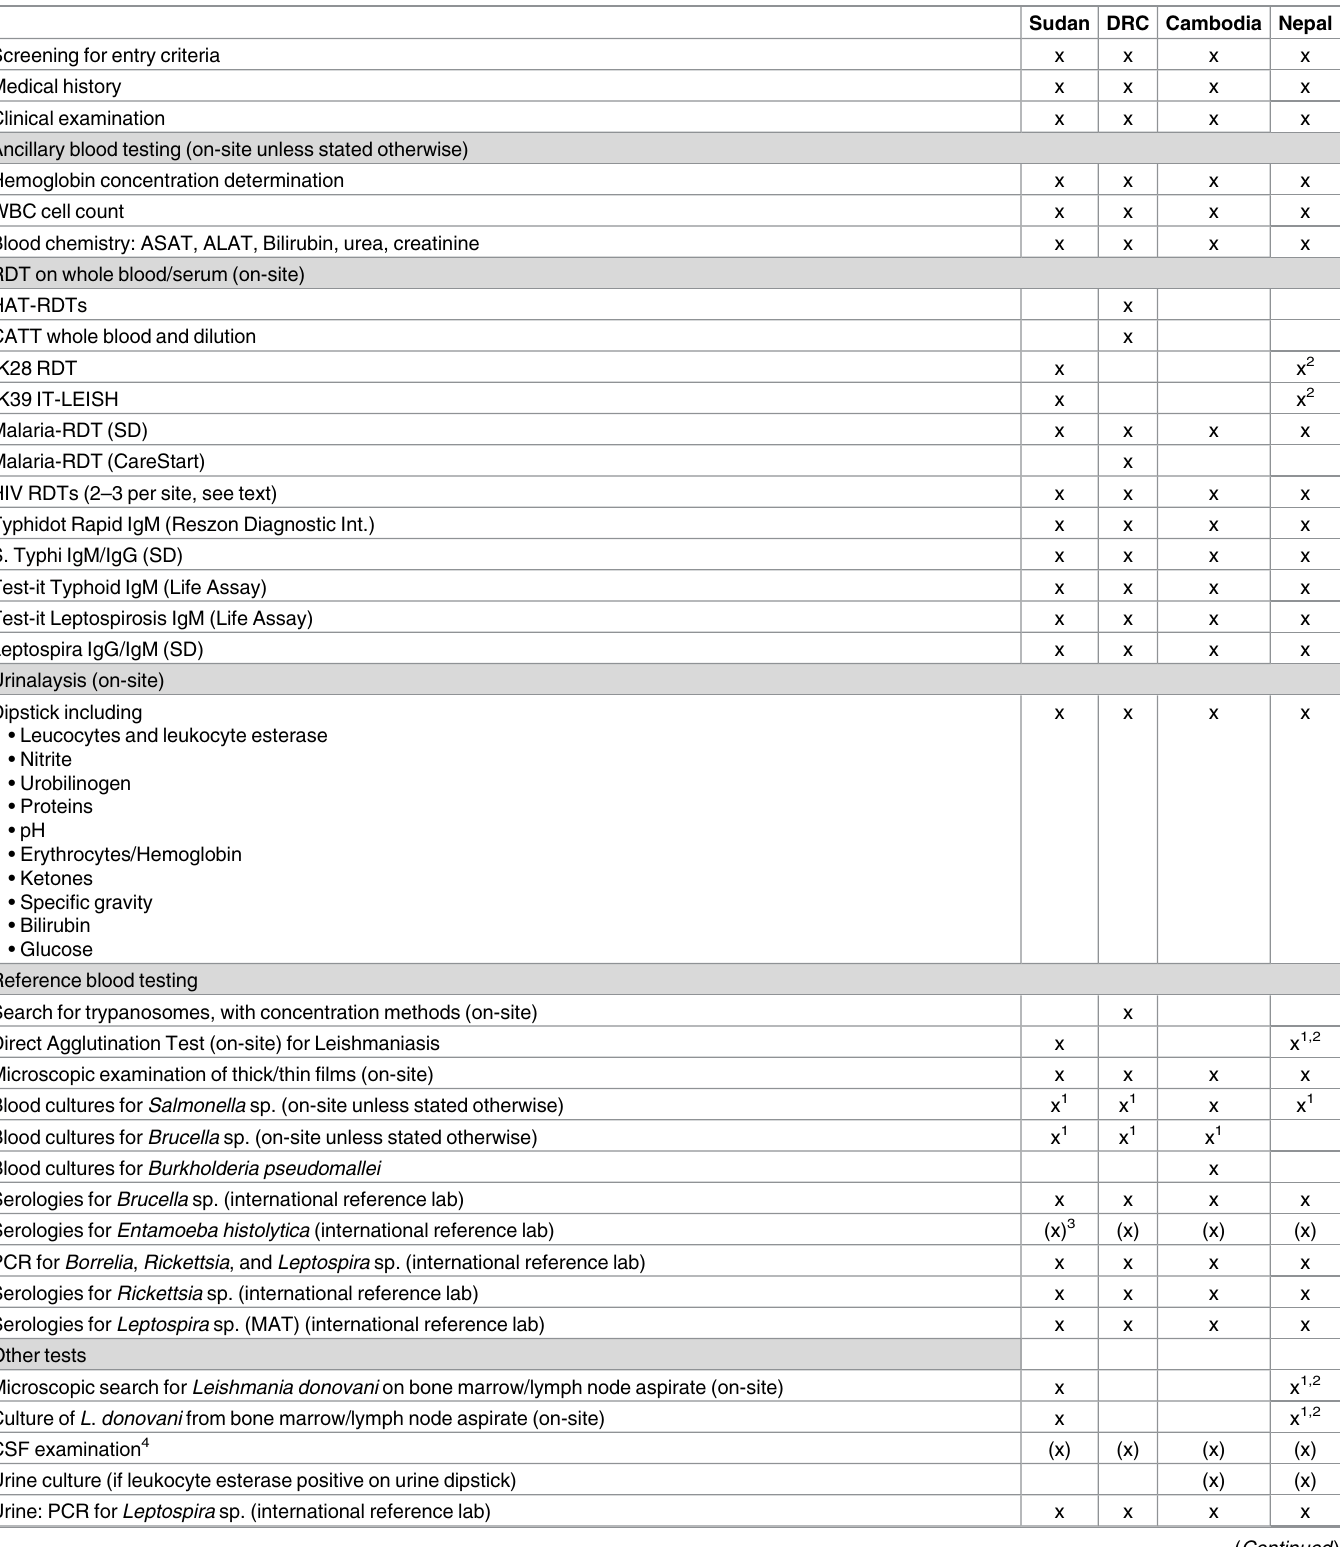
Table 1. Diagnostic plan for the NIDIAG persistent fever syndrome